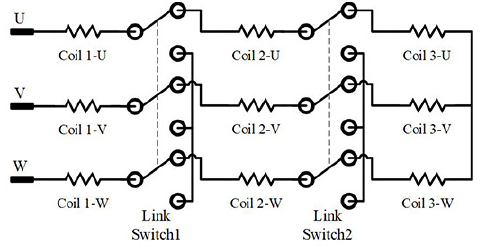
Figure 2. Coils connection between primary